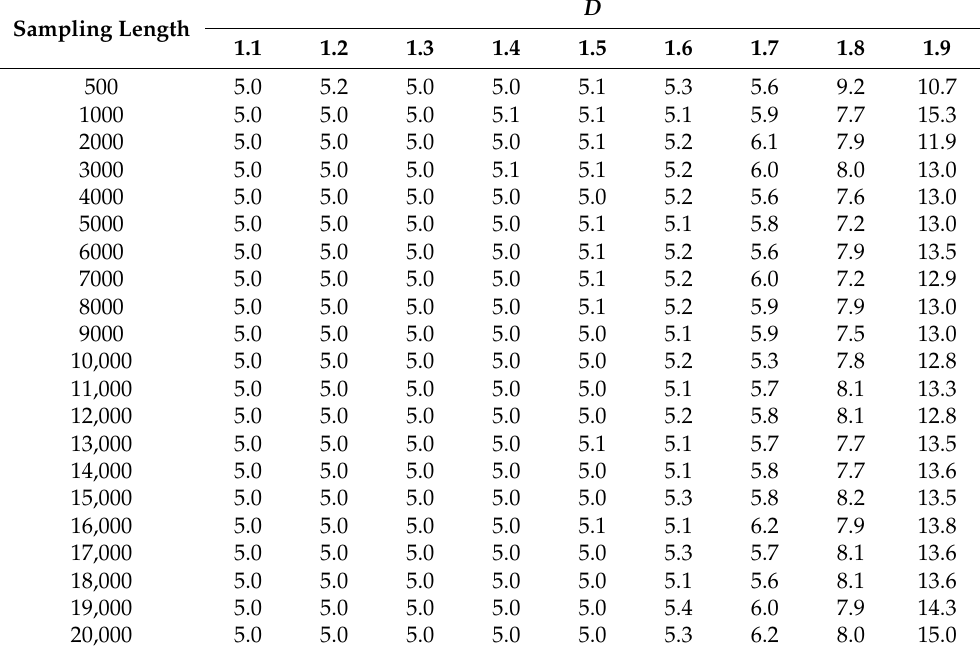
Table A5. Under all sampling lengths and all fractal dimensions, L d of drop points under the condition of 1-order flattening